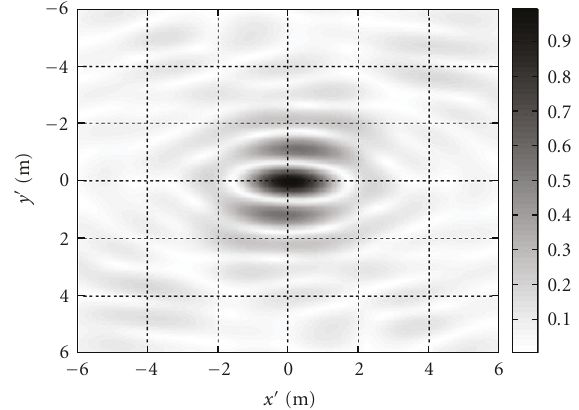
Figure 12: Image I of an isotropic point in the chosen configu- ration. SAL = 32km and N = 25 transmitters with a frequency spacing of